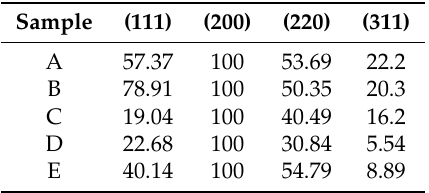
Table 3. Relative diffraction peak intensity of the samples after CT.